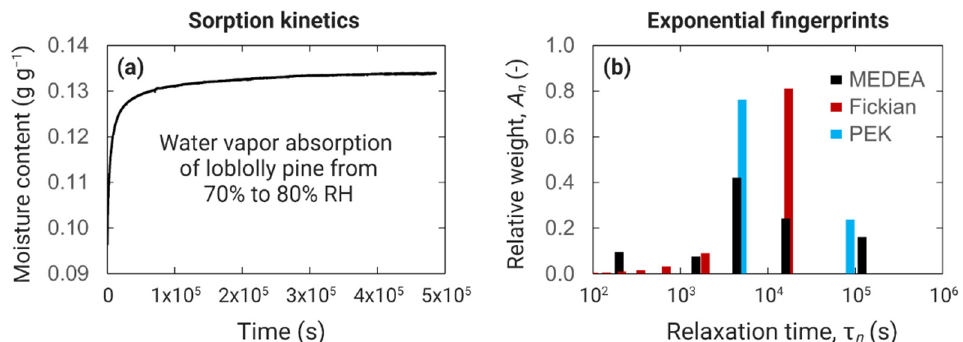
Figure 8. ( a ) Moisture sorption data for loblolly pine during absorption from 70% to 80% RH [81,82], and ( b ) the fingerprints of the experimental data analyzed by multi-exponential decay analysis (MEDEA) as well as fingerprints of the Parallel Exponential Kinetics (PEK) model and Fickian diffusion model after optimization of the fit to data [254,258].